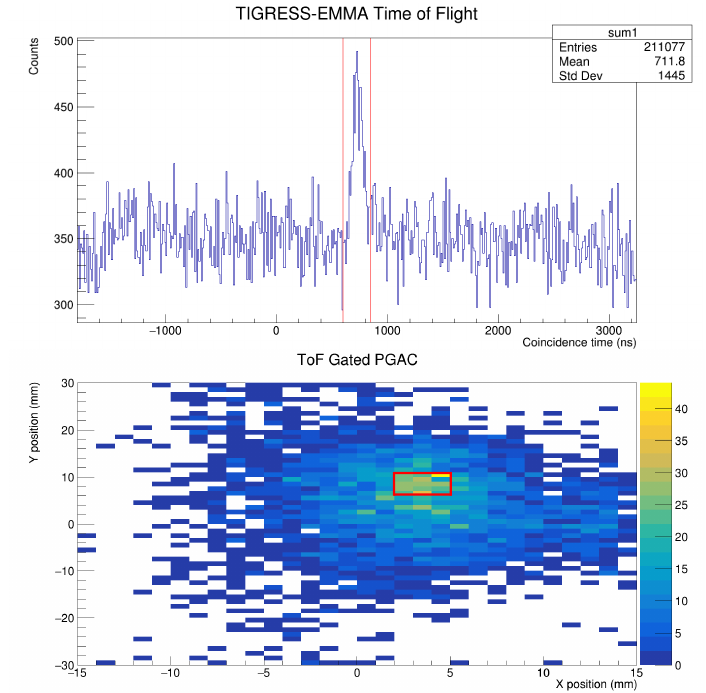
Fig. 1. Above: coincidence time gate between events in EMMA and events in TIGRESS. Below: focal plane gate set on the recoils measured by the EMMA PGAC (position-sensitive parallel grid avalanche